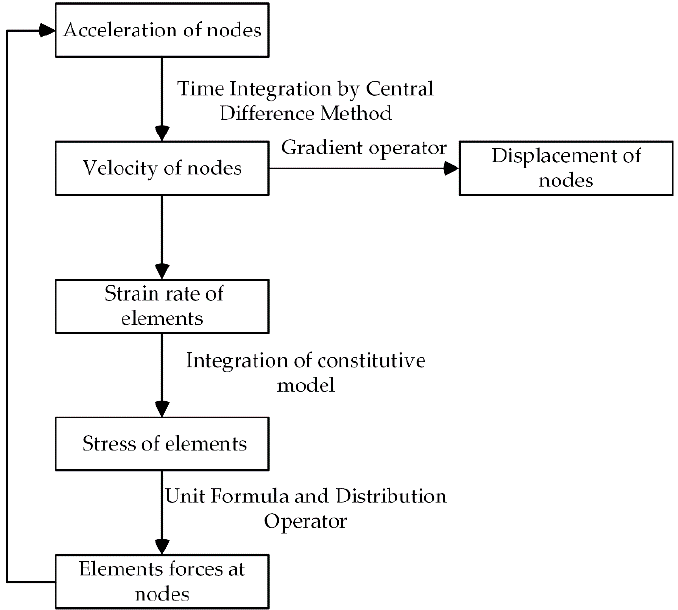
Figure 1. Flow chart of each time step. The solution process of ship–ice interaction is shown in Figure 2. The physical param- eters of ice and the information of ship motion are input at the beginning of the solution process. The contact between the ship and ice is judged and the interaction force is calcu- lated. Meanwhile, the stress and strain of ice are calculated. If the pressure or plastic strain reaches the value of failure, the failure element will be deleted; otherwise, the iteration continues. When the ice breaks off level ice, the edge of level ice is updated to calculate the new contact force in the next iterative step. The ice-breaking process and the ice loads are obtained through such iterative calculation.